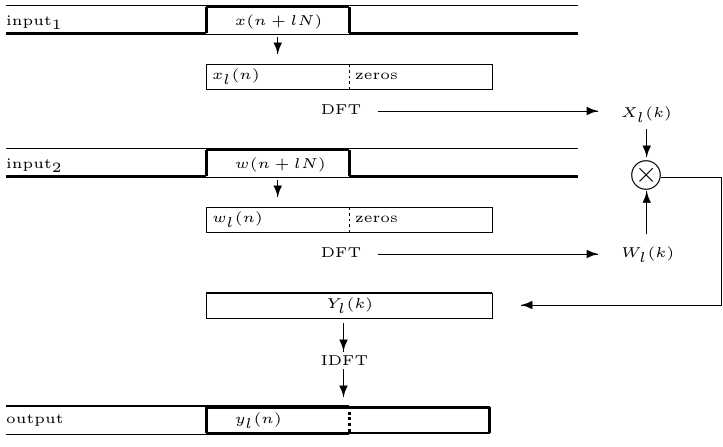
Figure 9. Fast overlap-add convolution, in this case using two arbitrary time-varying